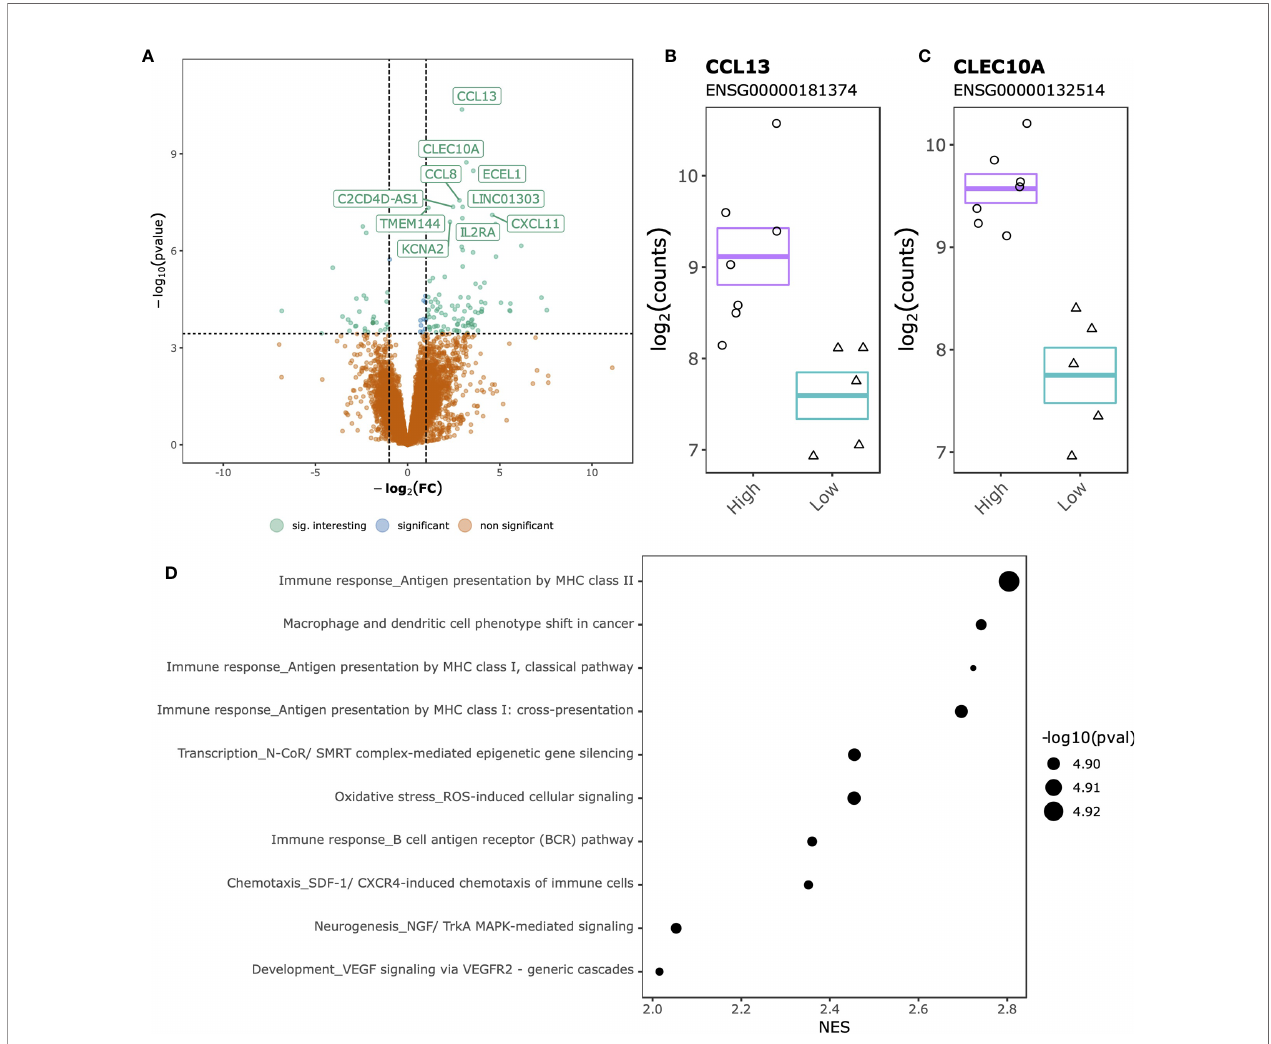
FIGURE 3 | SJC66 high versus SJC66 low differential expression analysis. (A) Volcano plots depicting the -log 10 ( p -value) on the y-axis relative to the difference in log 2 fold change when comparing the SJC66 high with SJC66 low samples on the x-axis. Colours represent the non-signi fi cant genes (orange), the signi fi cant genes (blue) and the signi fi cant genes with a log 2 fold change of larger than 1 (green; “ sig. interesting ” ). Statistical signi fi cance is further depicted by a dashed horizontal line. Mean and standard error bars superposed onto a jitterplot for the two most differentially expressed genes (B) CCL13 and (C) CLEC10A. (D) The 10 most enriched MetaCore gene sets associated to the DGEs. Tick marks represent gene ranks relative to the direction of the expression effect and are summarized by the normalized expression score